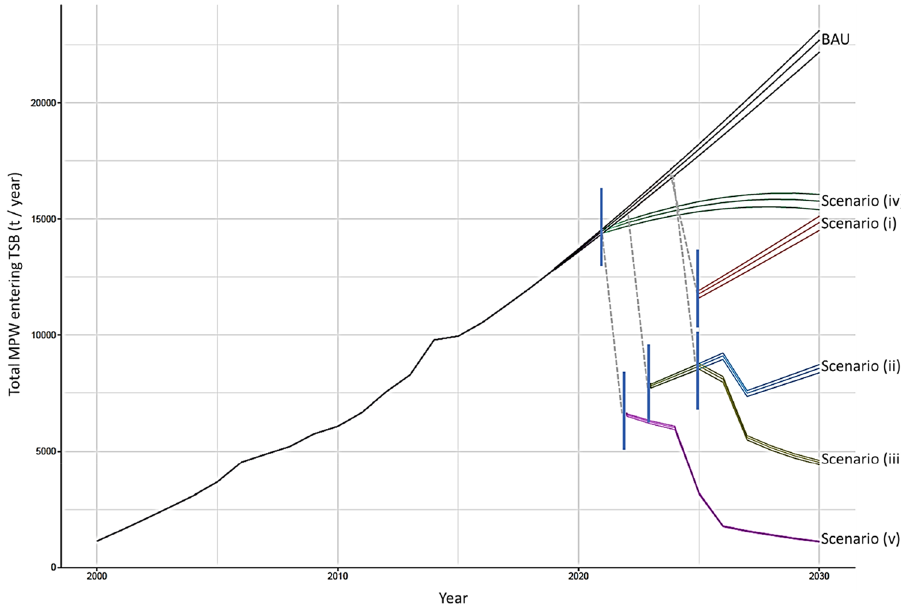
Figure 2. Five Scenarios (i to v) from 2021 to 2030, in addition to the Business as Usual (BAU) Scenario from 2000 to 2030. Error lines are shown as 95% prediction